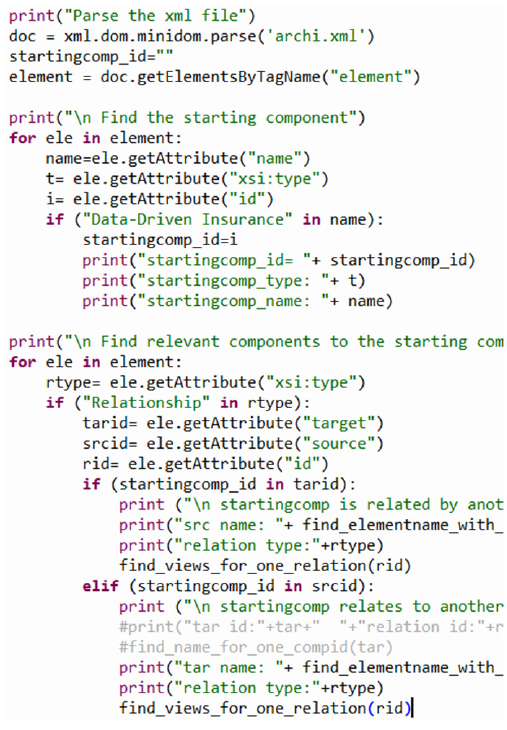
Figure 7. Sample code snippets for automatic slicing in Python.